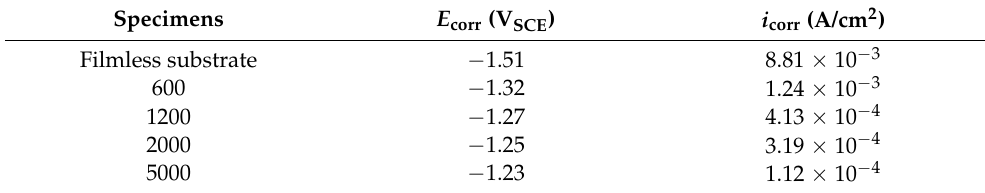
Figure 7. Tafel polarization curves in 0.1 M NaCl solution of ZnAl-LDH films grown on AZ91D Mg alloy with different surface roughness. Table 1. Corrosion potential ( E corr ) and corrosion current density ( i corr ) of different specimens derived from the Tafel extrapolation method .